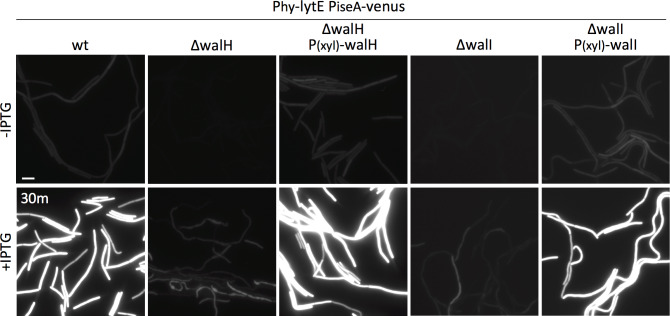
Complementation of ∆walH and ∆walI with xylose-regulated alleles.Representative fluorescent images of cells harboring the PiseA-venus reporter in wild-type (wt) or strains lacking either walH or walI, and complemented by either walH or walI under xylose-inducible control. Strains were grown in LB supplemented with 10 mM xylose to induce expression of walH and walI constructs and imaged before and 30 min after addition of 50 µM IPTG. Representative images are from one of three independent experiments. Scale bar indicates 5 µm.